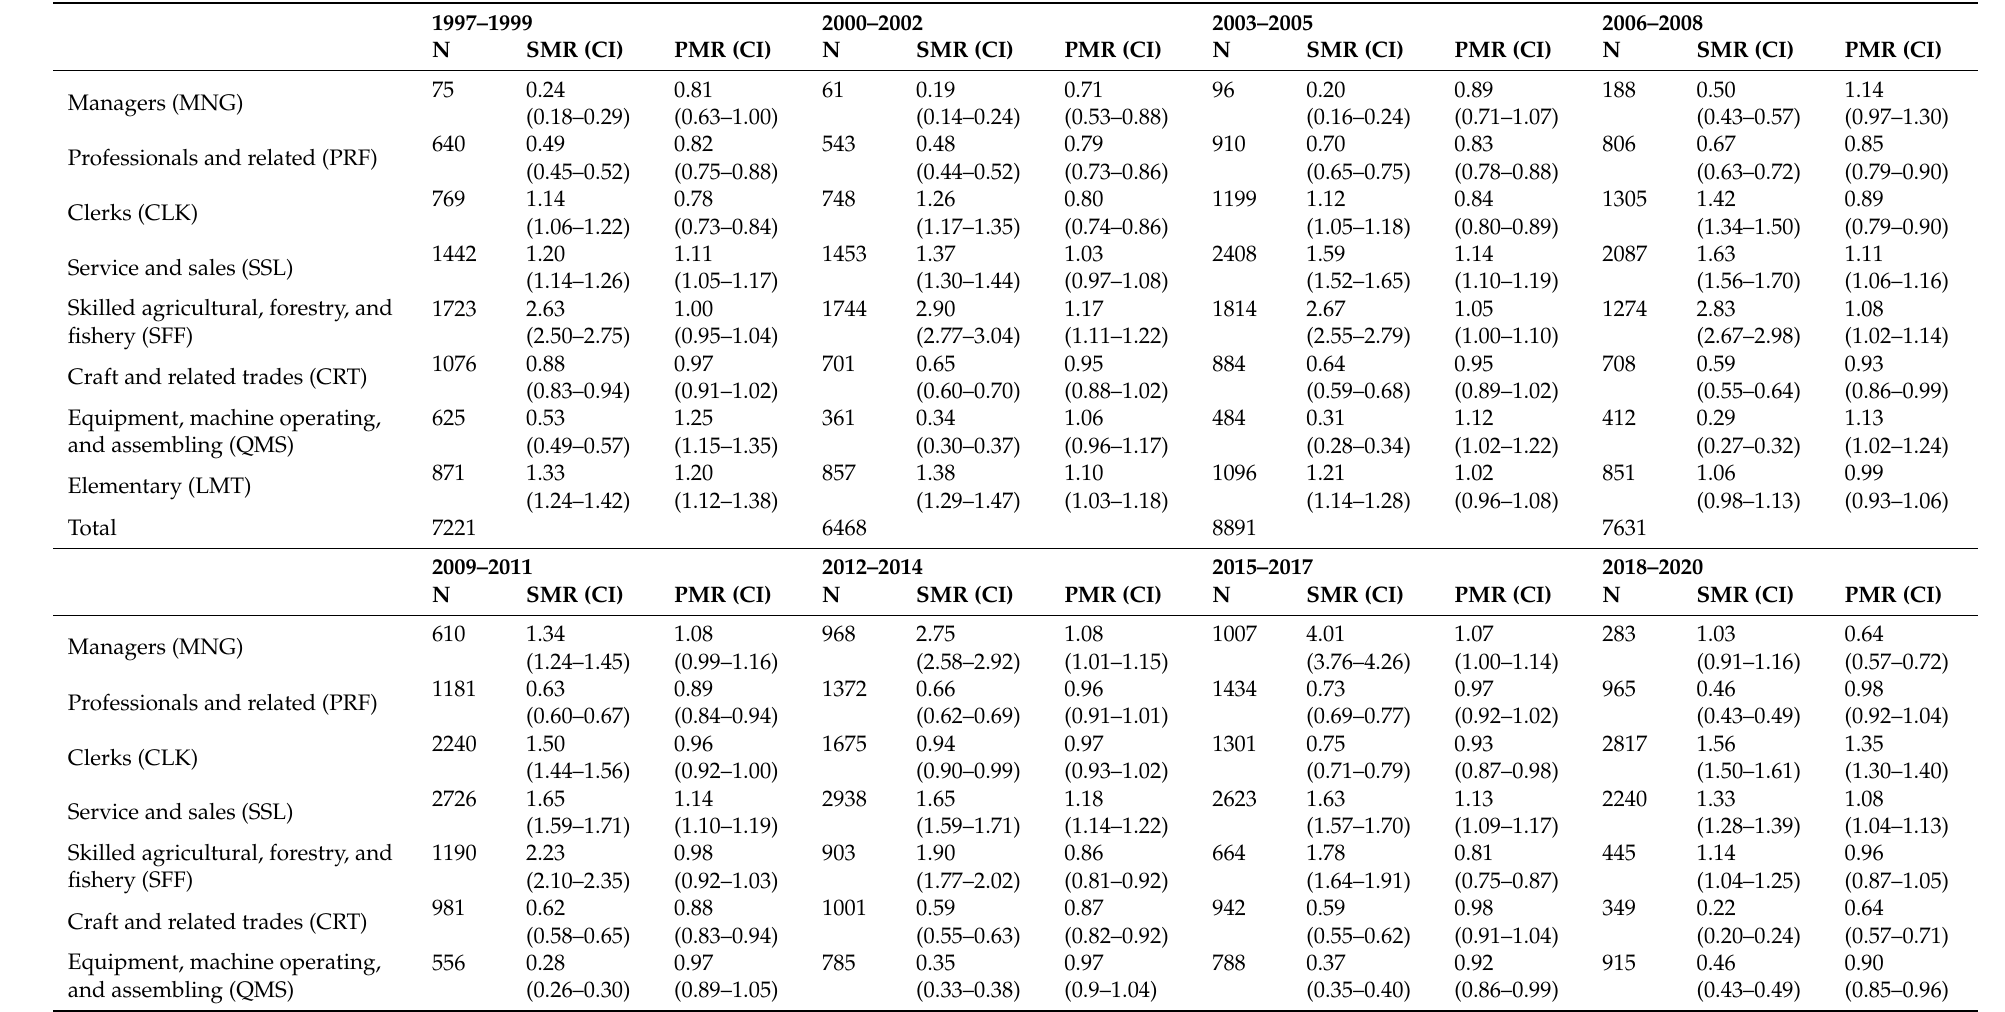
Table 1. SMR and PMR of male suicide by occupation, every 3